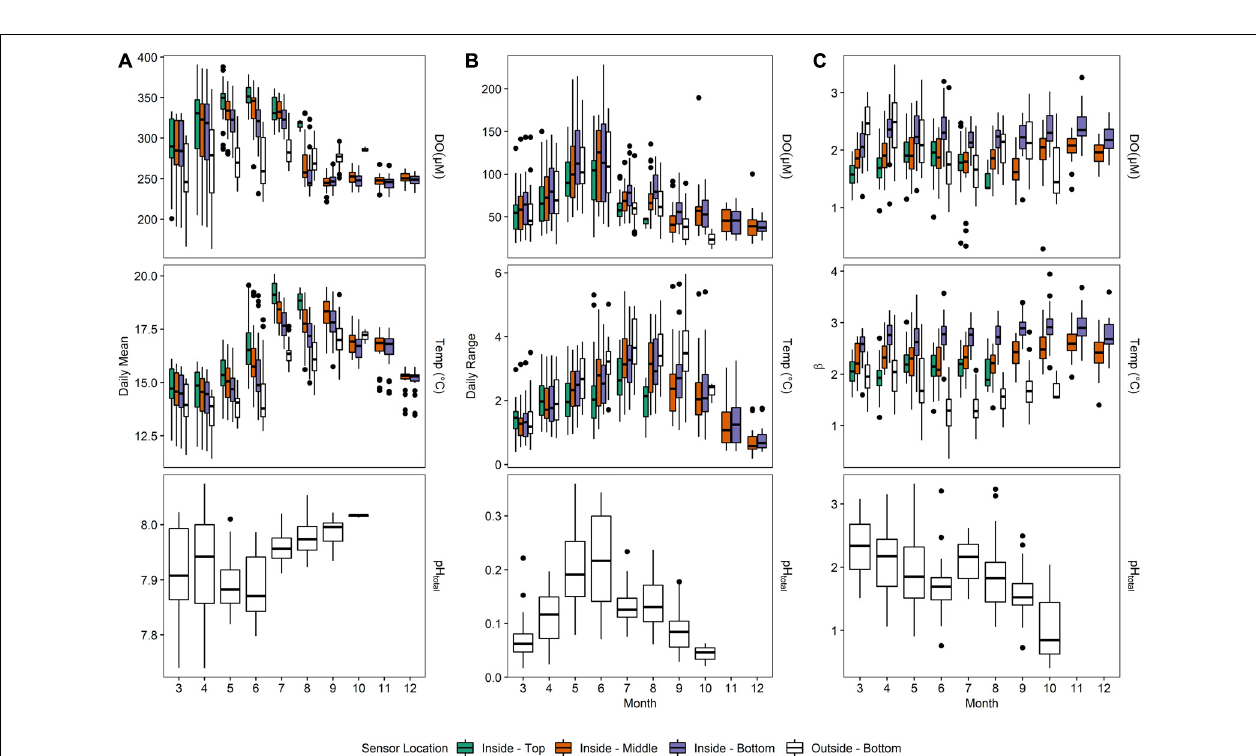
FIGURE 6 | Monthly means (A) , mean daily swings (B) and predictability indexes (C) for Deployment 3 (March – December 2016).